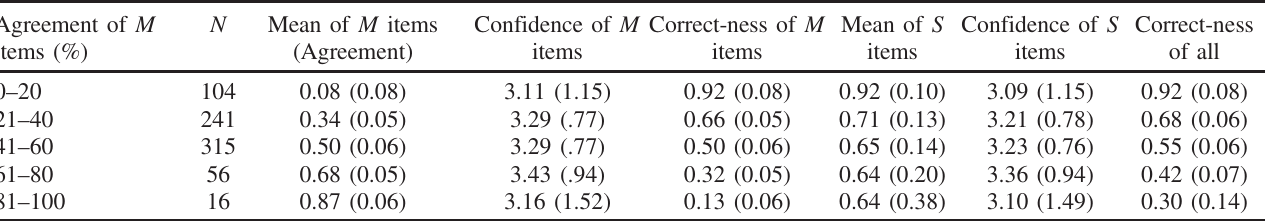
TABLE III. Distribution of the participants with varied scores in items about materialistic properties. Note that “ M items ” represent items regarding the materialistic property of sound; “ S items ” represent items regarding the process property of sound. Agreement of M